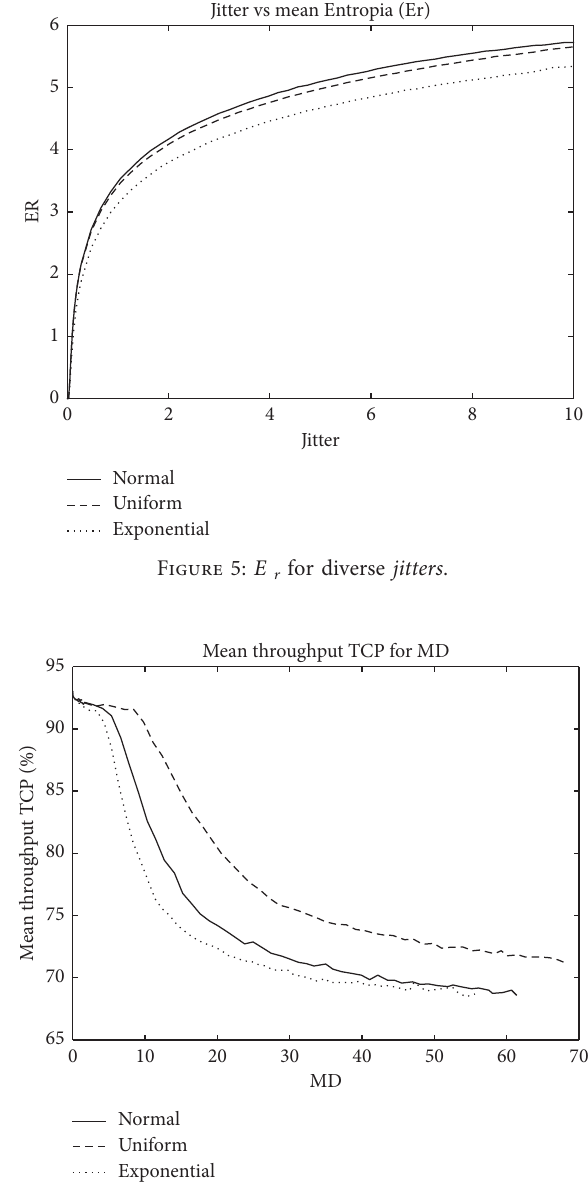
Figure 6: Throughput TCP for the values of MD